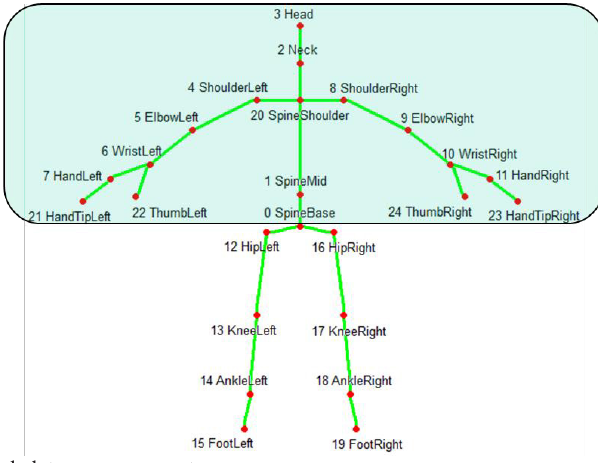
Fig. 1. Idea – remote control of robotic manipulators.